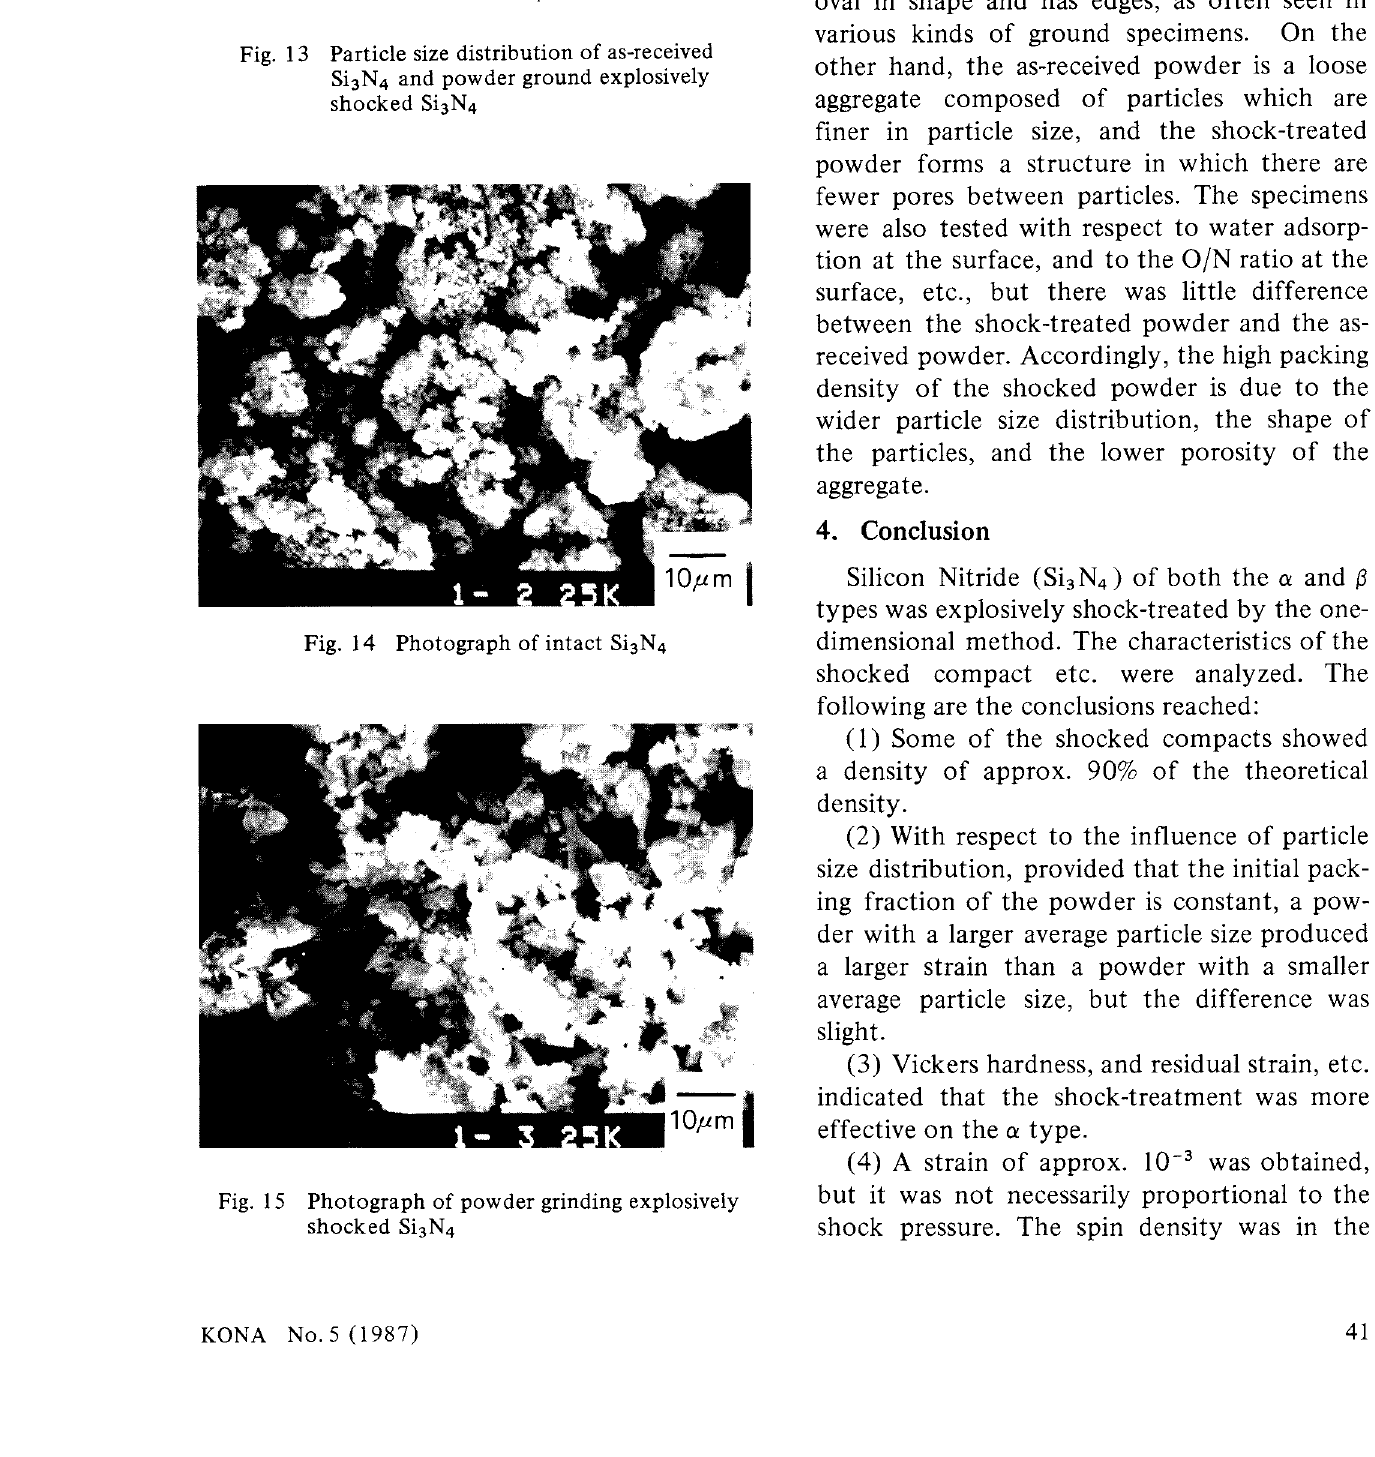
Fig. 13 Particle size distribution of as-received Si